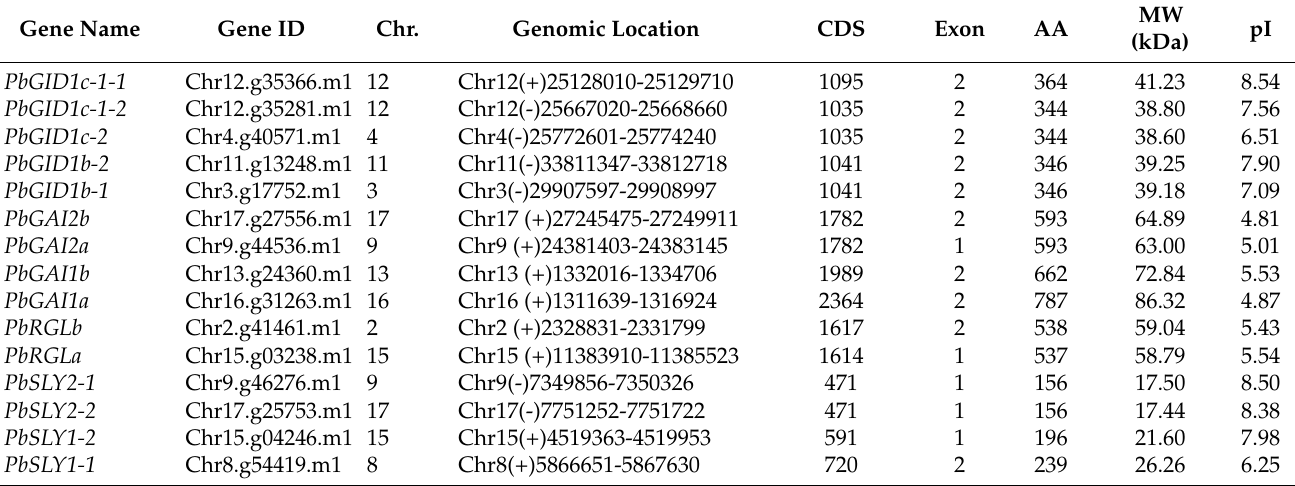
Table 1. Features of PbGID1, PbDELLA , and PbSLY genes identified from the genome of ‘ duli ’ pear ( Pyrus betulifolia